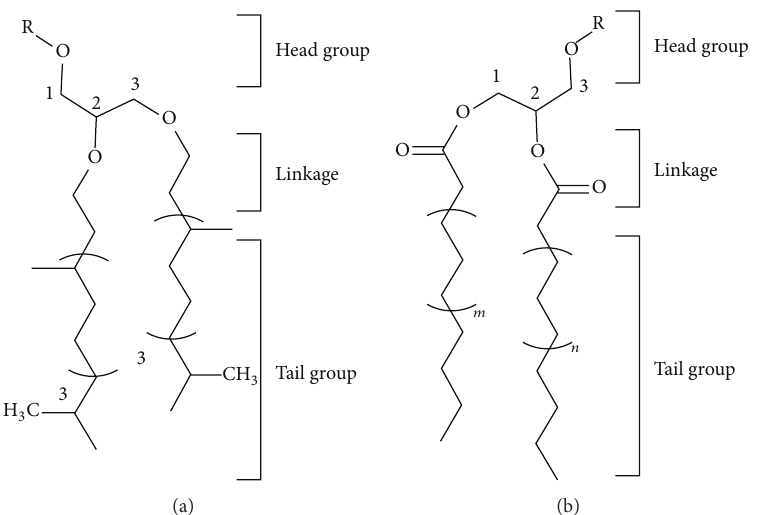
Figure 1: Structural representation of characteristic lipids used in archaeal and Prokaryotic/Eukaryota membranes. (a) Structure of a basic isoprenoid-based lipid used in archaeal membranes. (b) Canonical acyl chain-based lipid used in the formation of Prokaryotic/Eukaryota membranes. For each lipid, a head group consisting of any number of R groups connected to a glycerol molecule is depicted. Also attached to the glycerol head group are two hydrocarbon-based chains. The three major differences between the two types of lipids are in the chemical linkage to glycerol, the position on glycerol where the linkage takes place, and the type of hydrocarbon chain present. For archaeal lipids, five carbon isoprenoid units with a methyl group branched at every fourth carbon and are attached by ether linkages to glycerol at the 2 and 3 positions. For Prokaryotic/Eukaryota, hydrocarbon chains ( m and n in (b)) vary in length from 12 to 26 and are linked by ester bonds at the 1 and 2 positions to glycerol and not typically